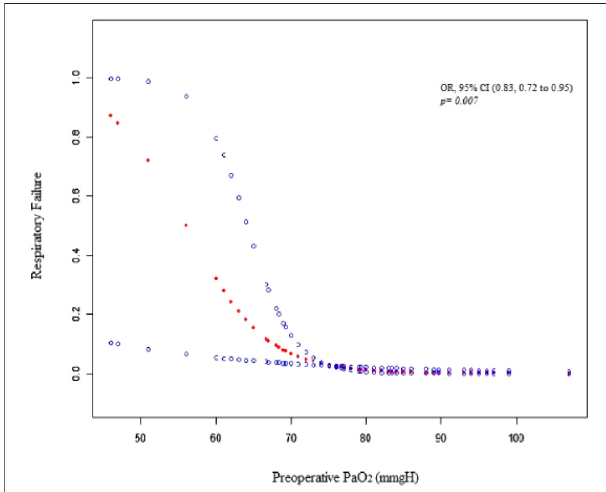
FIGURE 2 | Association of preoperative PaO 2 with respiratory failure.